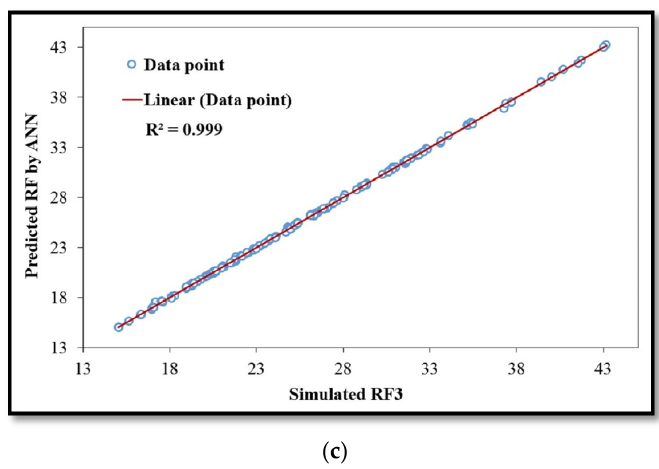
Figure 5. Correlation of recovery factor (RF) values between the simulated data and ANN prediction for ( a ) RF 1 , ( b ) RF 2 , and ( c ) RF 3 .